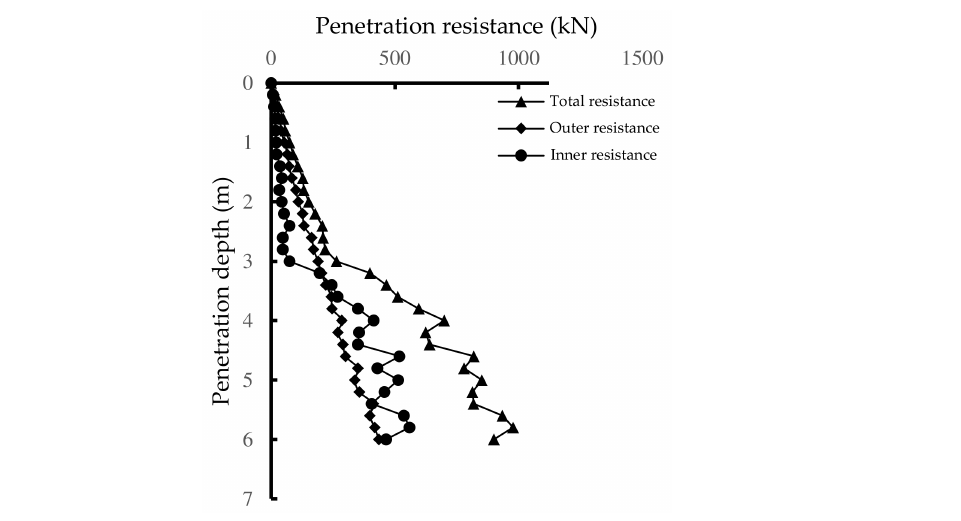
Figure 12. Penetration resistance curve for condition b